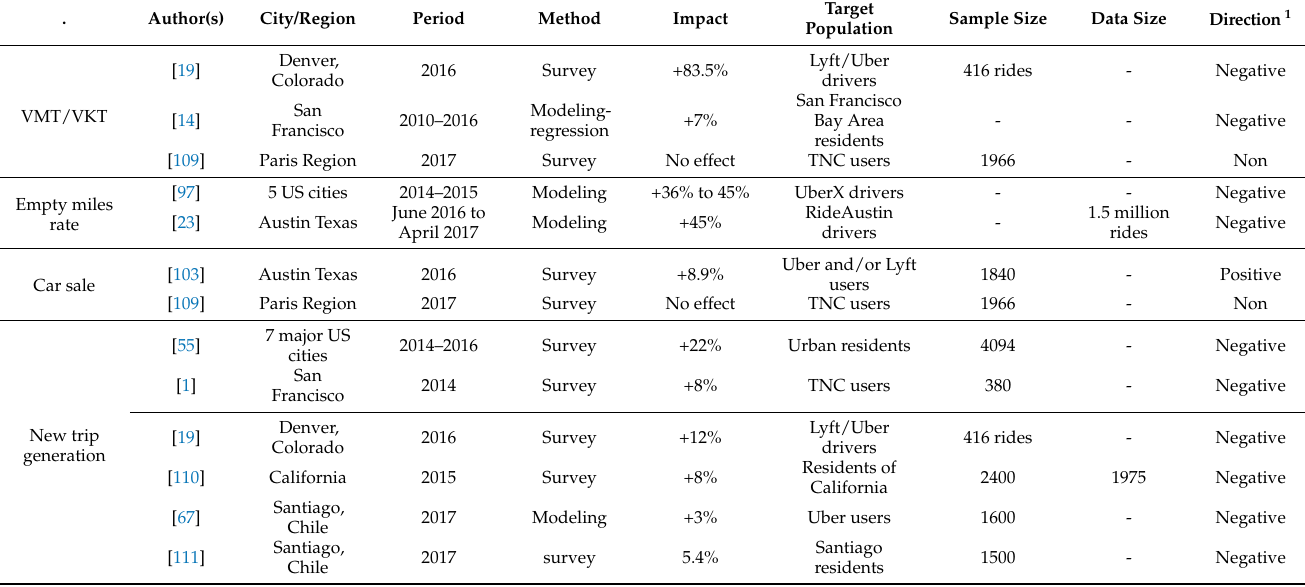
Table 2. The results of studies on the impact of ridesourcing services on VMT/VKT, empty miles rate, transit substitution, walking or bicycling substitution, driving/carpool/taxi substitution.